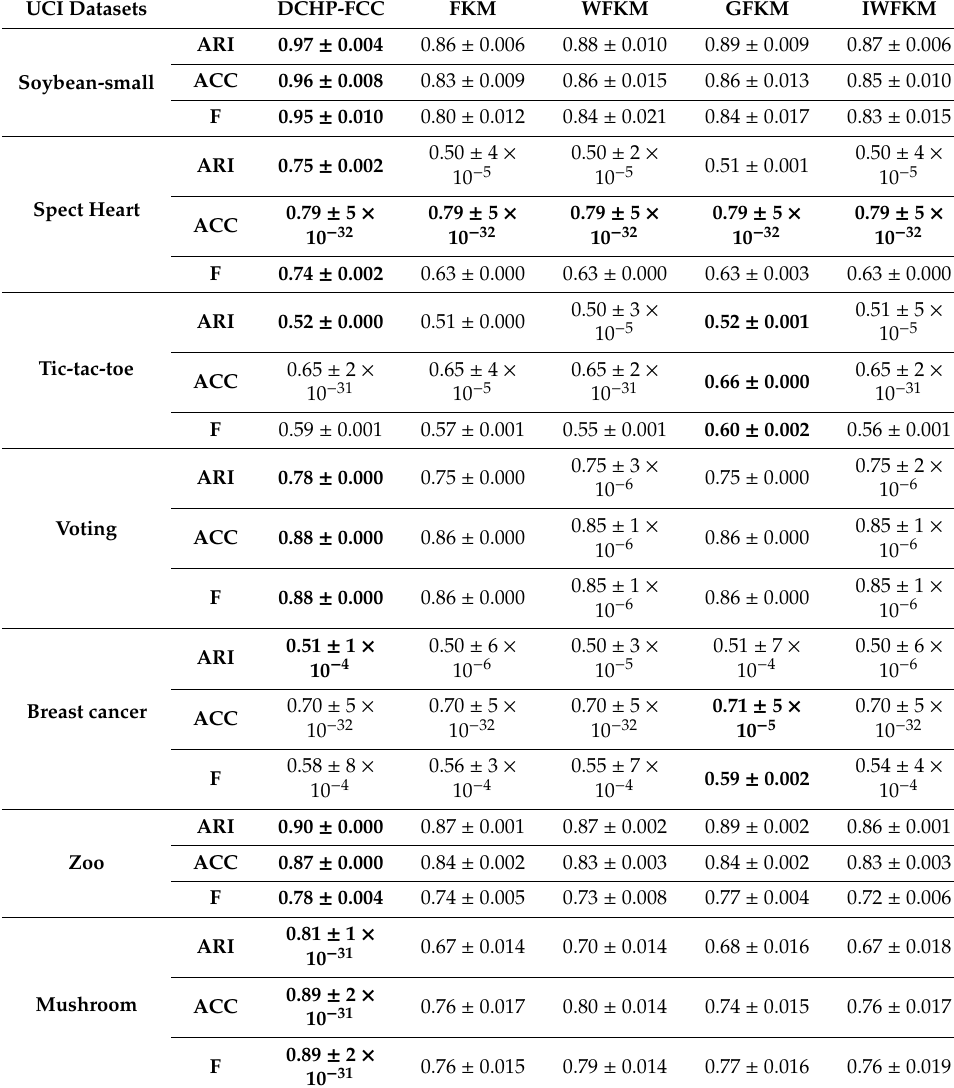
Table 4. The comparison of ARI, ACC and F-measure (F) benchmark for four clustering algorithms on seven datasets (mean ± std., BPs =